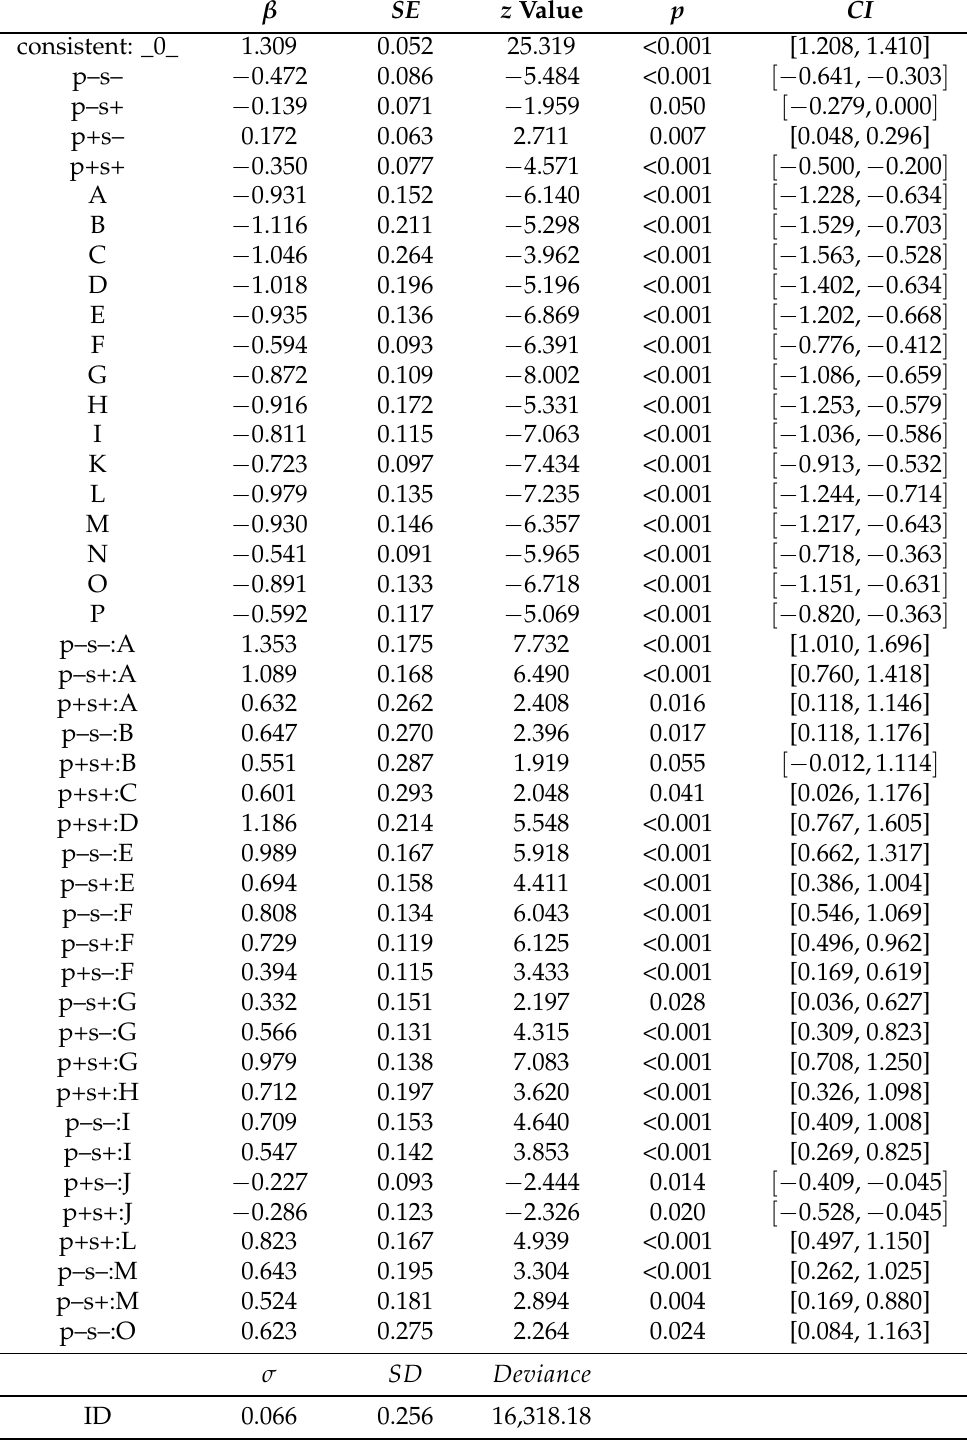
Table A7. Mixed model of the influence of specific stimuli conditions on the emospace widget